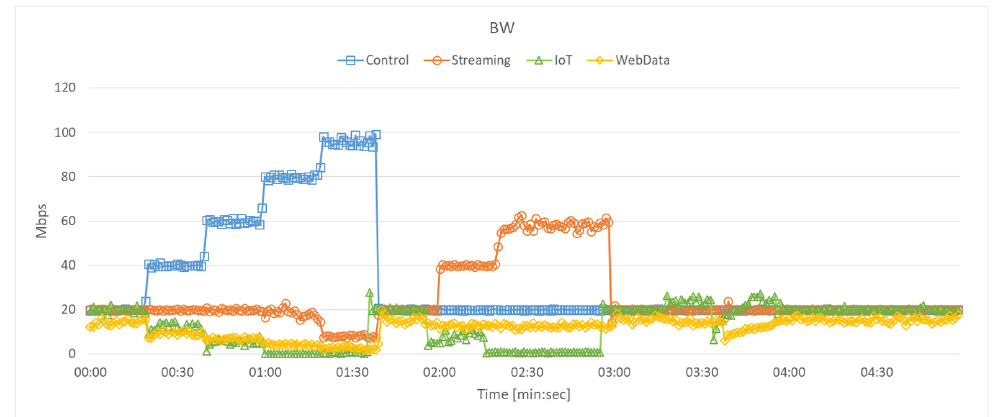
Figure 7. Bandwidth obtained from the scenario using the first